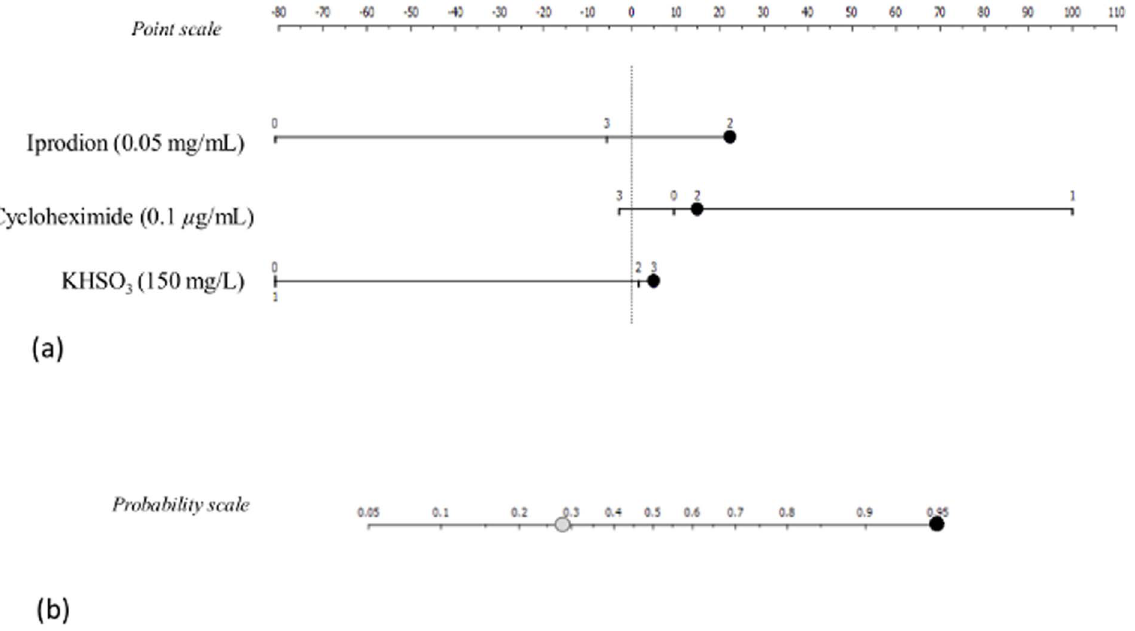
Figure 3. Nomogram showing naı¨ve Bayesian classifier results for the prediction of commercial strains based on phenotypic classes of growth for each test. ( a ) Performance of three phenotypic tests that contributed in a positive way to predict commercial strains; ( b ) Probability of predicting commercial strains when considering the entire phenotypic profile (grey circle), or only the three phenotypic tests mentioned in panel (a) by the blue dots (black